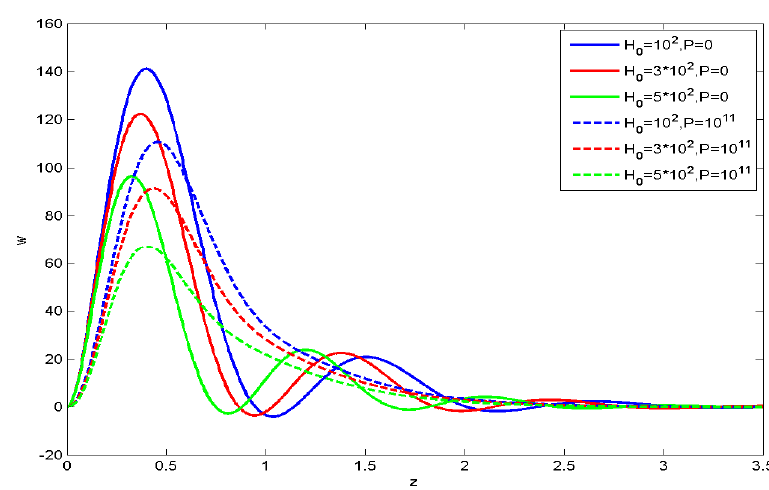
Figure 19. Vertical displacement distribution w concerning z with magnetic field H 0 .